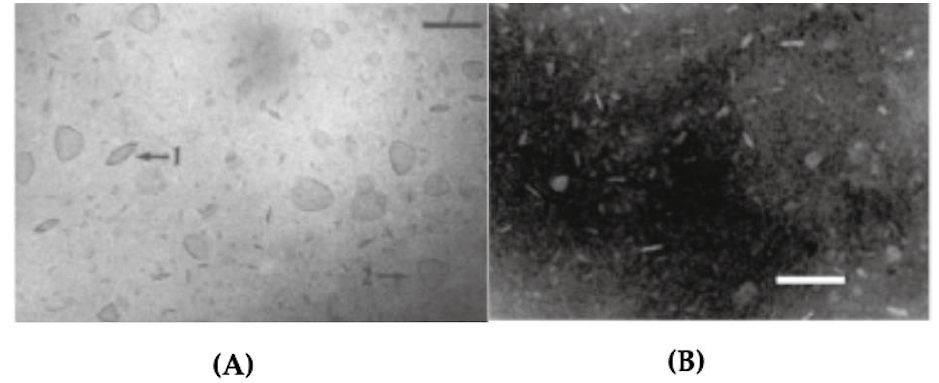
Figure 19. Lipid bilayer fragments of cationic and anionic synthetic lipids. ( A ) Bilayer fragments of dioctadecyldimethylammonium bromide (DODAB) visualized by cryo-transmission electron micrograph. Adapted from [278] with permission from 1995 American Chemical Society. ( B ) Bilayer fragments of sodium dihexadecylphosphate (DHP) visualized by transmission electron micrograph after negatively staining the sample. Disks were observed edge-on or face-on. Bars denote 100 nm Adapted from [279] with permission from 1991 American Chemical Society